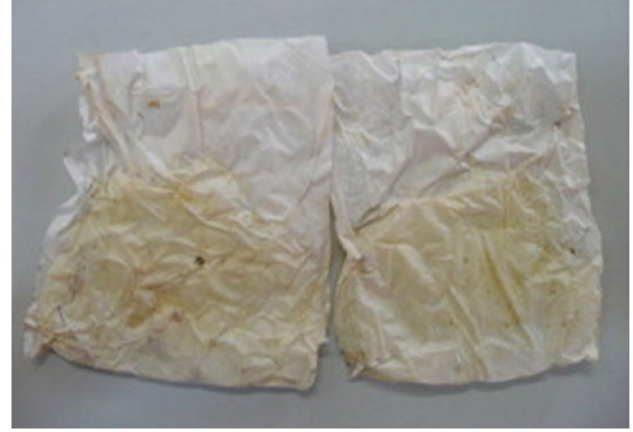
Figure 4. Pictograph of a PLA Biophan 121 pouches after HP sterilization (700 MPa at 115 °C for 5 min) containing solid carrots as packaged foodstuff, reprinted with permission from Ref. [54], copyright (2022) Elsevier.